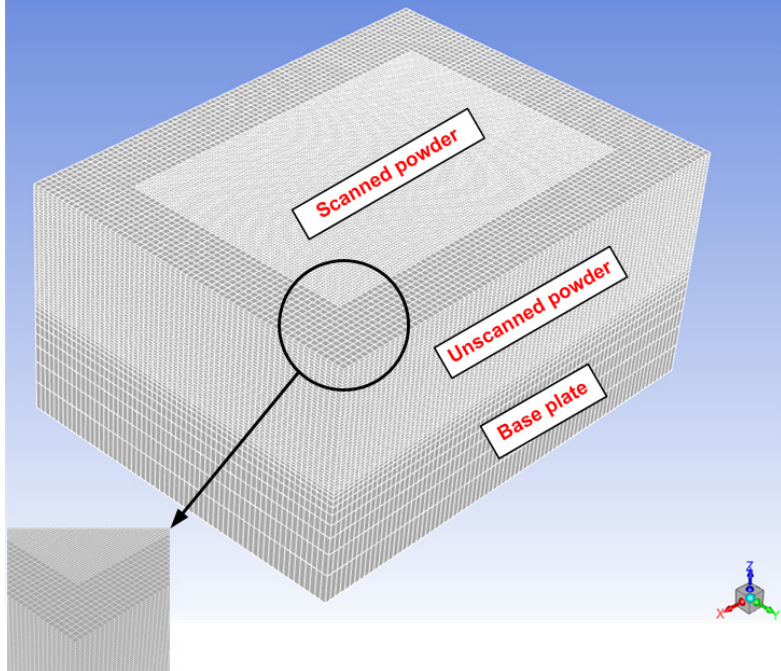
Figure 3. The mesh (computational domain) used in this study (not to scale).